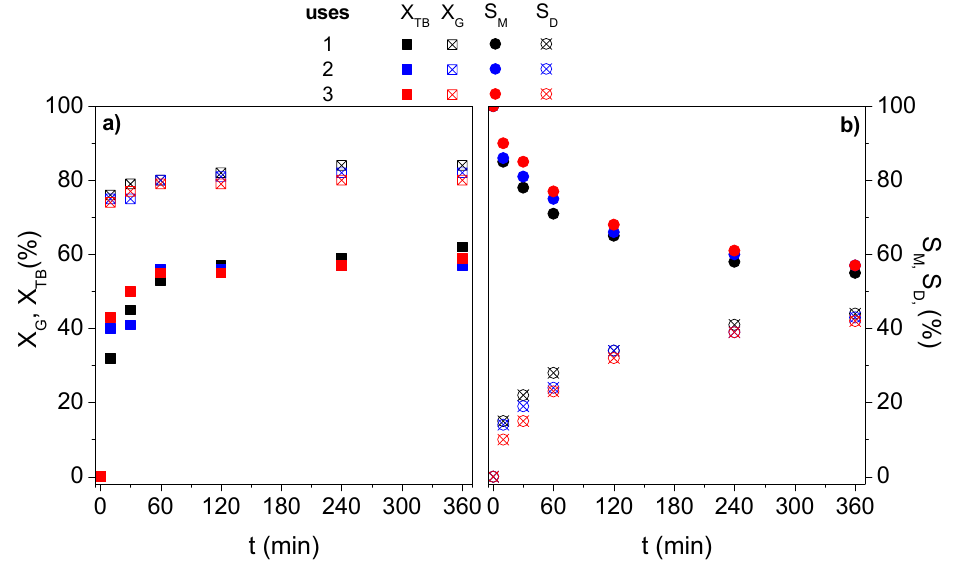
Figure 8. Influence of reaction temperature on G and TB conversion ( a ) and M and D selectivity ( b ) with reaction time. Operating conditions: 70 °C, 4 bar, G:TB = 1:3, DBE:TB = 1:2, C cat =20% (R1, R9 and R10).